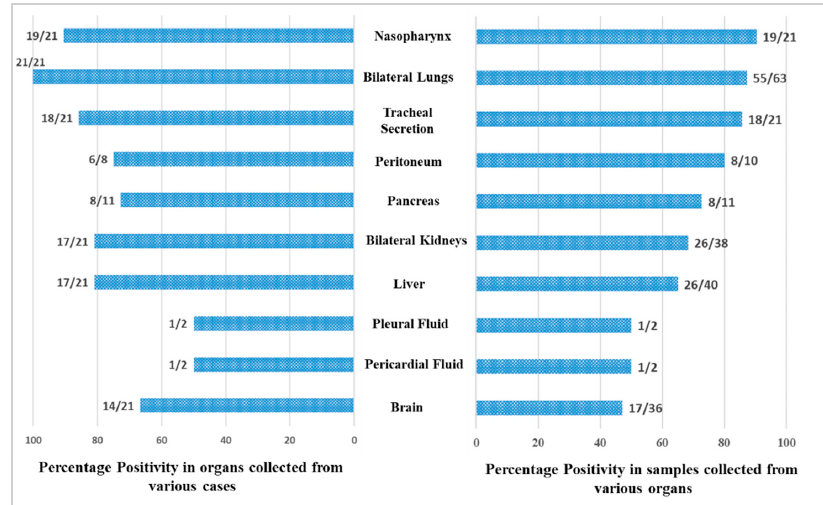
Figure 2. Positivity of the organ samples from the autopsied patients.